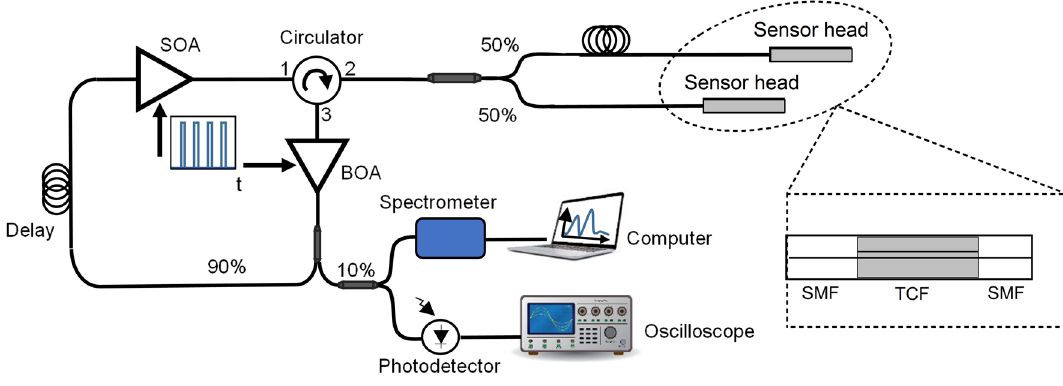
Figure 1. Schematic of the interrogation